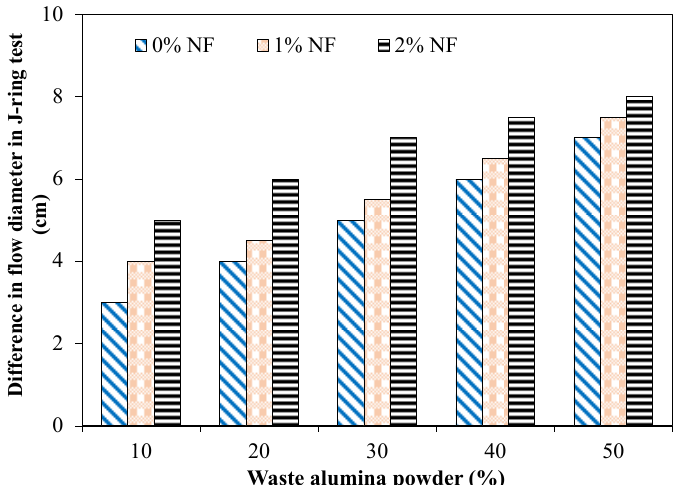
Figure 6. Difference in flow diameter in the J-ring test for mixtures incorporating AP and NF.